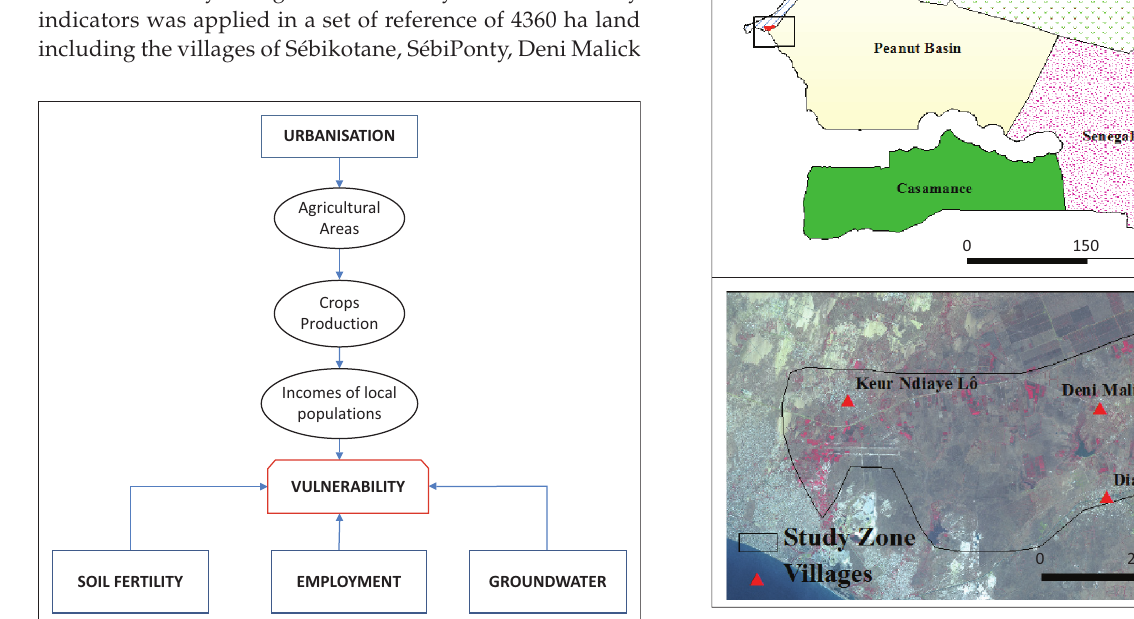
FIGURE 2: Localisation of the study area. (a) Agro-ecological zones and (b) villages of the Niayes